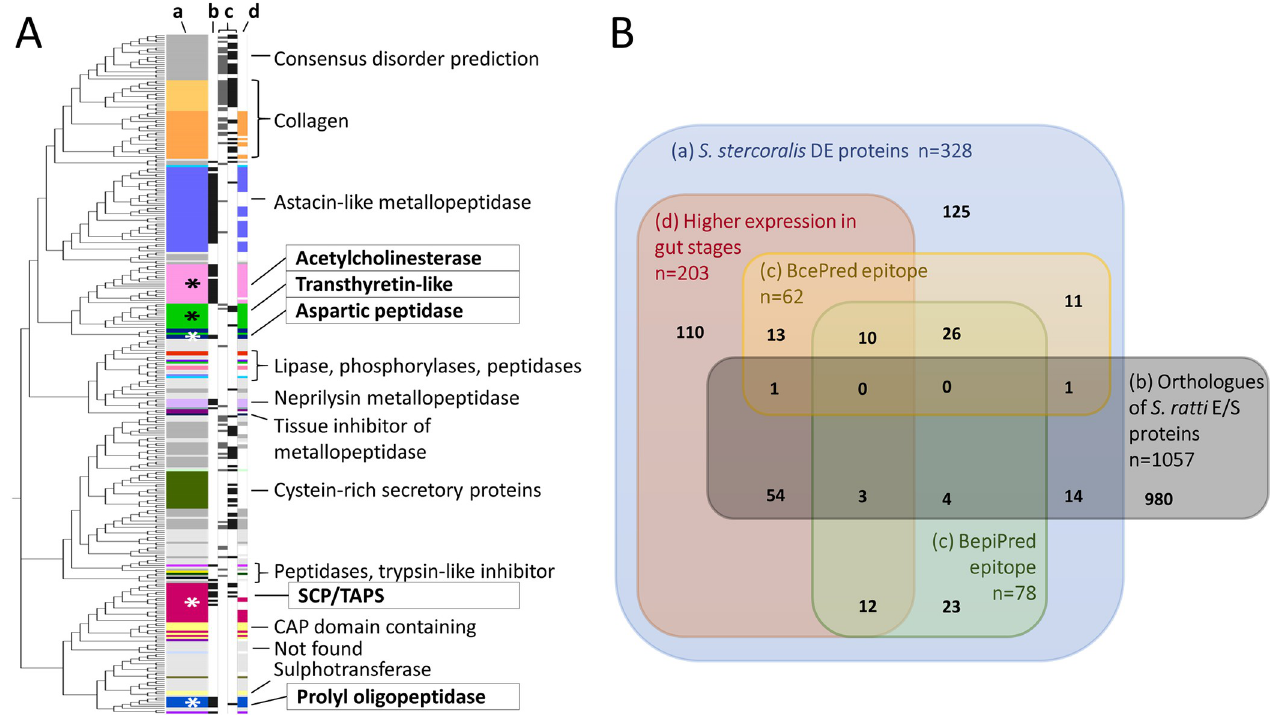
Fig 3. Strongyloides stercoralis proteins differentially expressed (DE) between gut-dwelling and non-gut-dwelling life stages and their overlap with other analyses. Panel A; DE proteins grouped by sequence similarity with protein families identified. Colours refer to features or families; the 5 priority protein families analysed in depth (SCP/TAPS; TTL; AChE; aspartic peptidases, and POP) are labelled with an asterisk and boxed text; pale grey indicates proteins not identified by any method, dark grey indicates disordered proteins. Panel B, overlap, in numbers of proteins, between the DE proteins and other analyses. In both panels, labels indicate: a, the 328 S . stercoralis DE proteins; b, proteins orthologous to S . ratti E/S proteins; c, proteins containing epitopes predicted by BcePred (left in Panel A) and BepiPred (right in Panel A); d, the 203 proteins that were DE in gut-dwelling life stages. Gene accession numbers and all protein family names for the DE proteins can be found in S2 and S4 Files for E/S orthologues. These results originate from methods in Fig 1, boxes C-H and